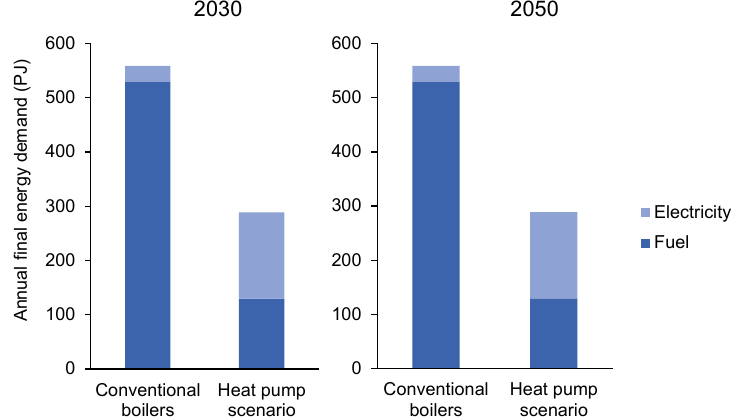
Figure 7. Annual final energy demand in the textile wet-processing industry in China .